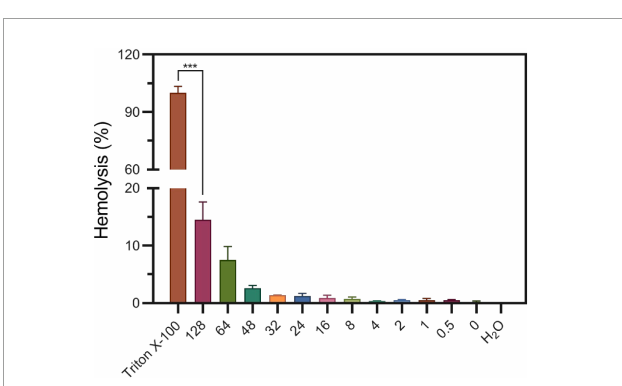
FIGURE9 Hemolysis of S2303 on human blood cells. 1% Triton and H 2 O are regarded to trigger 100% hemolysis and 0% hemolysis, respectively. In other groups, RBCs were treated with different concentrations of S2303 ( µ g/mL). 0 µ g/mL S2303 is equals to 1% Dimethyl sulfoxide (DMSO). T -test was checked between RBCs treated with 1% Triton X-100 and 128 µ g/mL S2303 and P -value is less than 0.001 (***). Each point represents the average of data from three assays. The standard errors represent the error bars of the